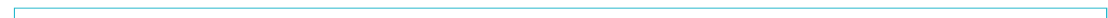
Figure 2: Schematic representation of the mode of action of P140. Right side: In antigen presenting cells (APCs), lysosomal compart- ments (lysosomes and autophagosomes) derive to MIIC. In this compartment, antigenic peptides resulting from endogenous processing sys- tems (e.g., autophagy, proteasome; dotted arrow) and exogenous pathways of antigen processing, are loaded onto MHCII molecules, which are then presented to the plasma membrane (thin arrows) and able in this context to recruit/activate CD4+ T cells via their receptor (TCR). This step requires co-stimulatory molecules expressed by T cells such as CD28, which interacts with CD80 (B7.1) and CD86 (B7.2) on the membrane of the APC, or CD40 ligand, which is primarily expressed on activated T cells. In lupus, which is characterised by dysfunction of T cells, polyclonal B-cell activation and failures occurring in several immune compartments, the cascade of events is hyperactivated (differentia- tion of T cells, autoreactive B cells, maturation into plasma cells and production of autoantibodies). Pro-inflammatory cytokines and chemokines are produced by these hyperactivated lymphocytes. Autoantibodies, alone or linked to self-antigens (forming thus circulating im- mune complexes) can induce inflammatory reactions after their deposition in targeted tissues. Left side: In the presence of P140 peptide, the whole (hyperactivated) process is slowed. Shortly after its intravenous administration to MRL/lpr mice, P140 enters MRL/lpr B-lymphocytes acting as APCs via a clathrin-dependent endo-lysosomal pathway and accumulates at the lysosomal lumen where it can interact with lysoso- mal HSPA8 and hamper its chaperone function in CMA (experimentally shown in vitro ). This correlates with the observation that P140 de- creases the overexpression of LAMP2A (a rate limiting factor in CMA) in MRL/lpr B cells in vivo and of MHCII molecules. Loss of HSPA8 chap- eroning function and destabilisation of LAMP2A induced by P140 may thus interfere with the endogenous (auto)antigen processing and loading to MHCII molecules, which are then destabilised, leading to lower (or no more) activation of autoreactive T cells and B cells, and con- sequently to an improvement of autoimmune condition observed in mice and patients with